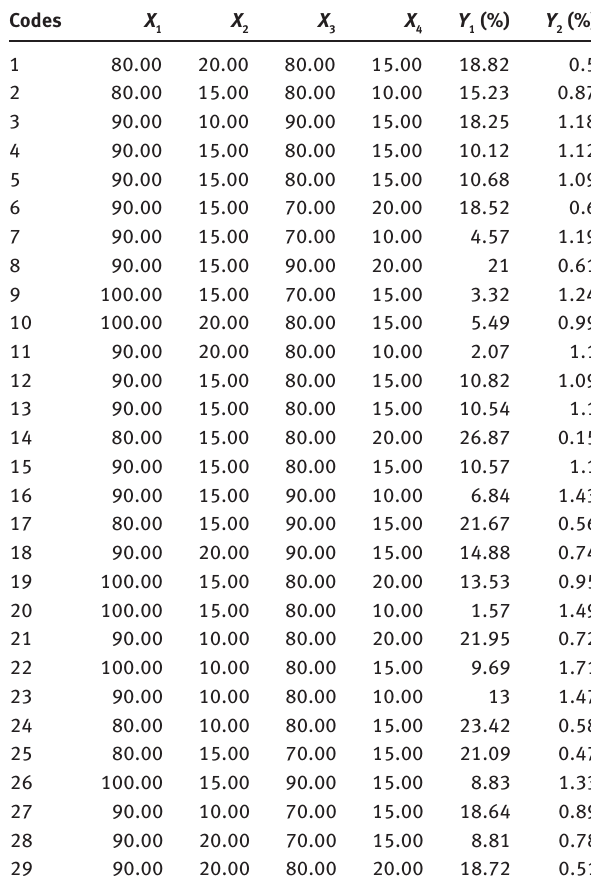
Table 3: Box–Behnken experimental design and results.